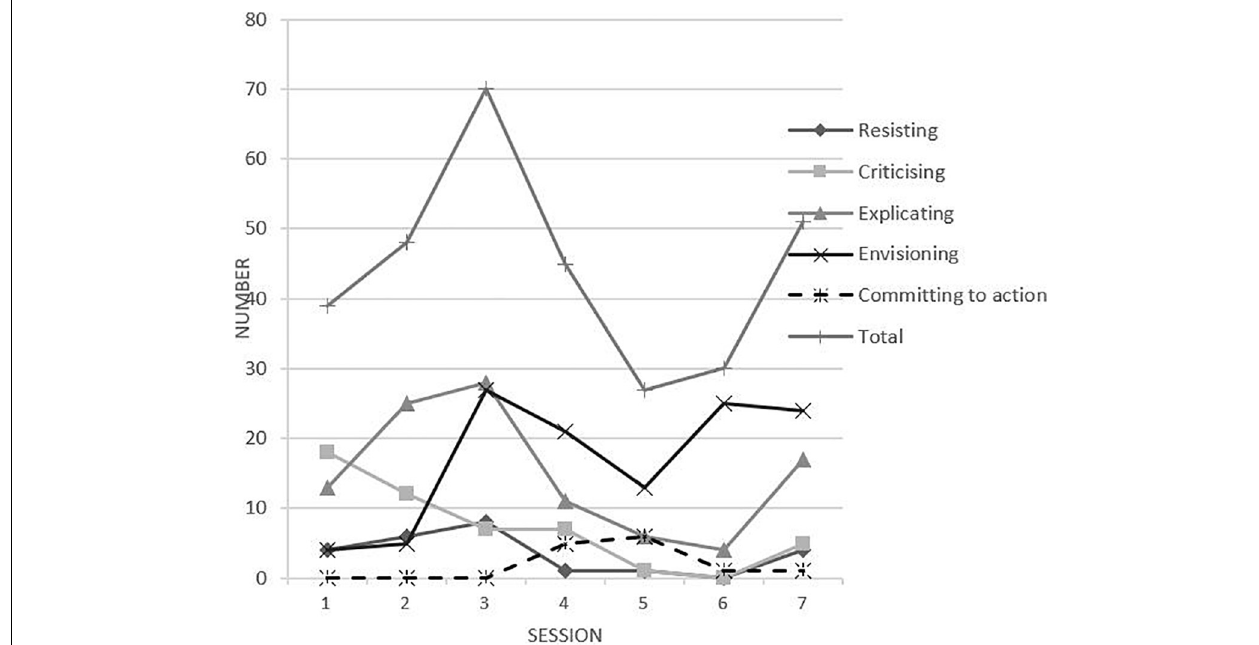
FIGURE 1 | The transformative agency in every session.